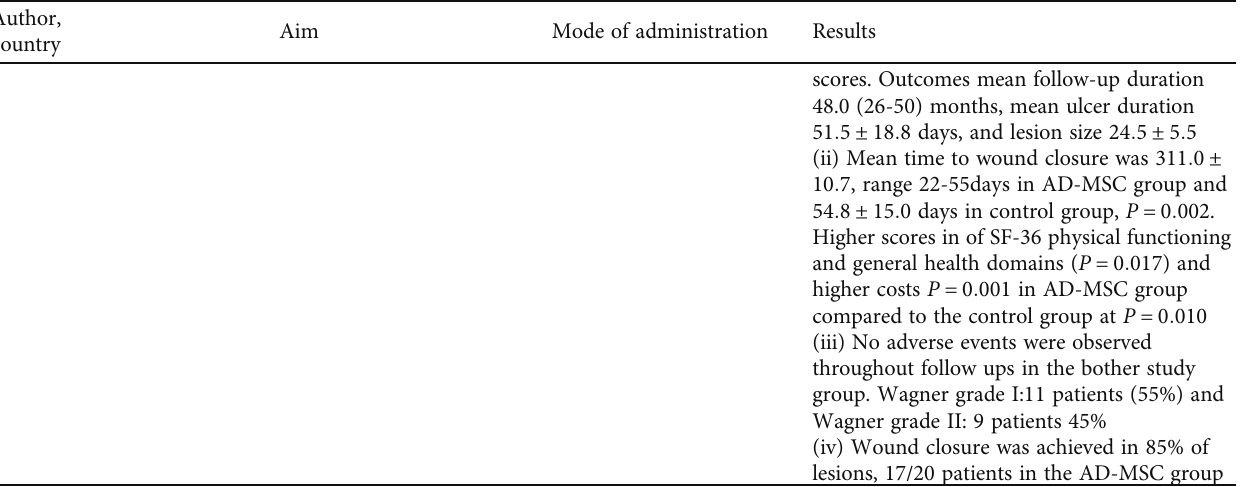
Table 4: Selected studies on stem cell therapy for diabetic foot ulcer, number of enrolled subjects, dropouts, and endpoints. Participated ( n Study Enrolled ( n )